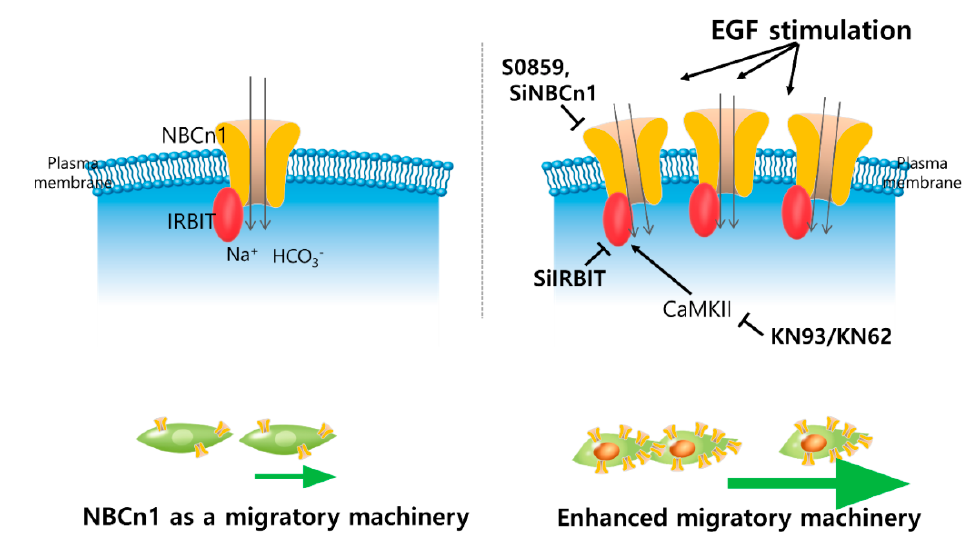
Figure 8. Schematic illustration of function of NBCn1 as a migration machinery and regulatory factors on NBCn1-mediated migration in lung cancer cells. IRBIT protein is recruited to NBCn1, plays a positive role in the migration of lung cancer cells and stored expression of NBCn1 in the plasma membrane as a stimulated condition with EGF. NBC inhibitor S0859, knockdown of NBCn1 or IRBIT, CaMKII inhibitor KN93 attenuate the NBCn1-mediated cellular migration.